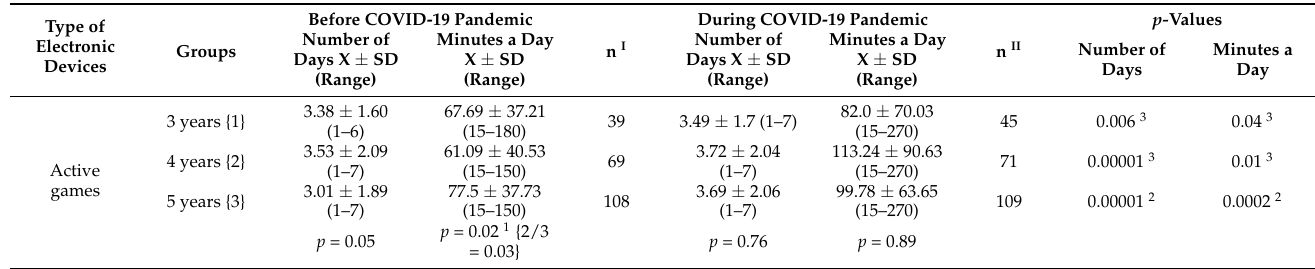
Figure 5. Average values of sleeping time in groups of children aged 3–5 years. 3.6. WHO Guidelines